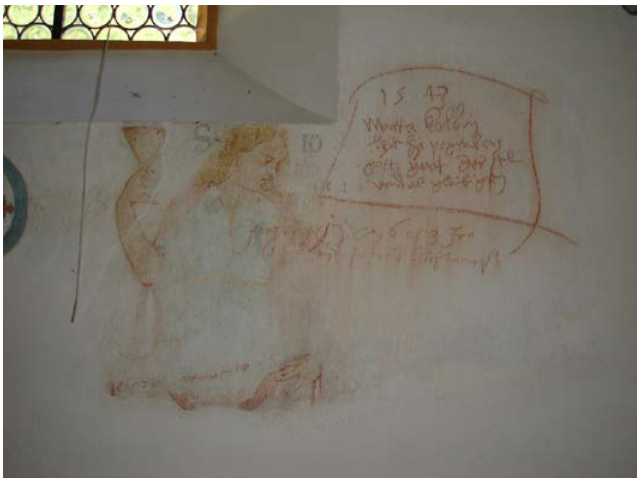
Figure 5 – This memorial inscription for Marta Kolb was written after her death on the Southern wall of the St. Vigil church, Obsaurs, Northern Tyrol. Photo by Romedio Schmitz-Esser. Courtesy of the